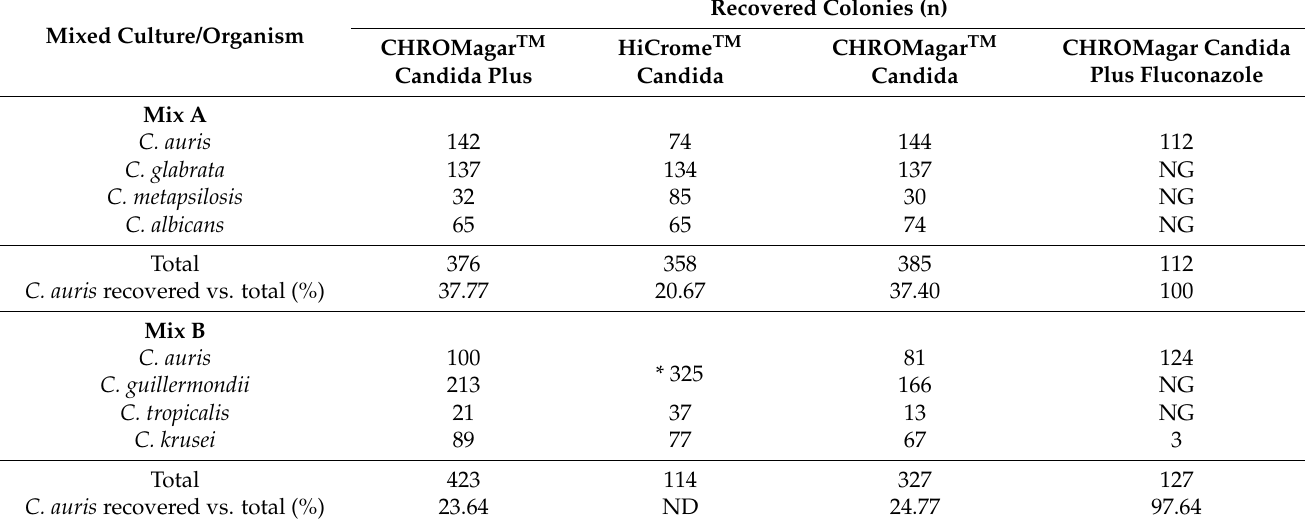
Table 1. Comparison of CHROMagar TM Candida Plus, HiCrome TM Candida, CHROMagar TM Can- dida, and CHROMagar Candida supplemented with 32 mg/L of fluconazole for the recovery (CFU) of mixed cultures after 48 h of incubation at 35 °C.